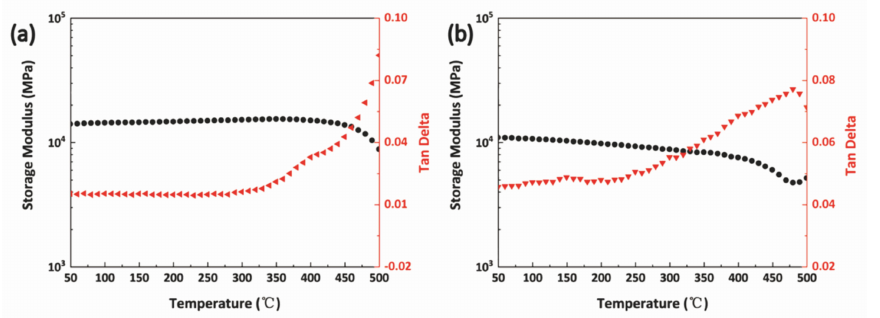
Figure 10. DMA curves of ( a ) BPh-Q 10 and ( b ) BPh-B thermosets. The heating rate is 5 ◦ C/min and the frequency is 1.0